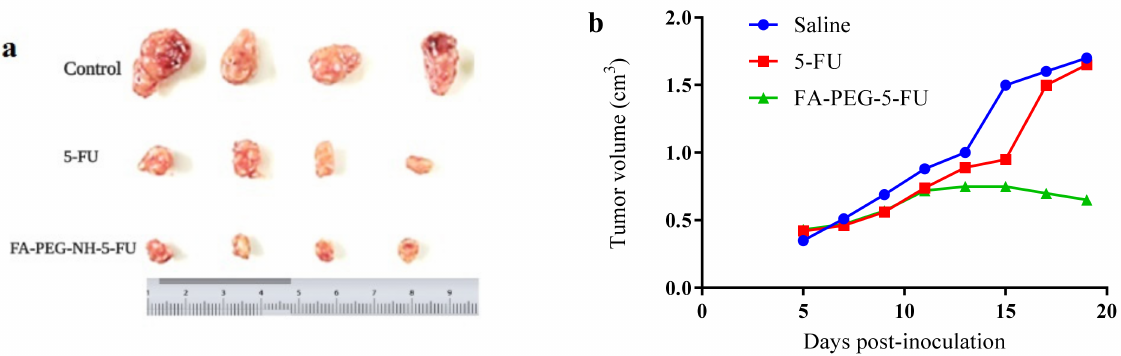
Figure 4. ( a ) Tumor sizes after administration; ( b ) tumor weights at 5, 10, 15, and 20 days post inoculation. Data in Table 1 illustrate the index of organ to body weight. They show that the folate